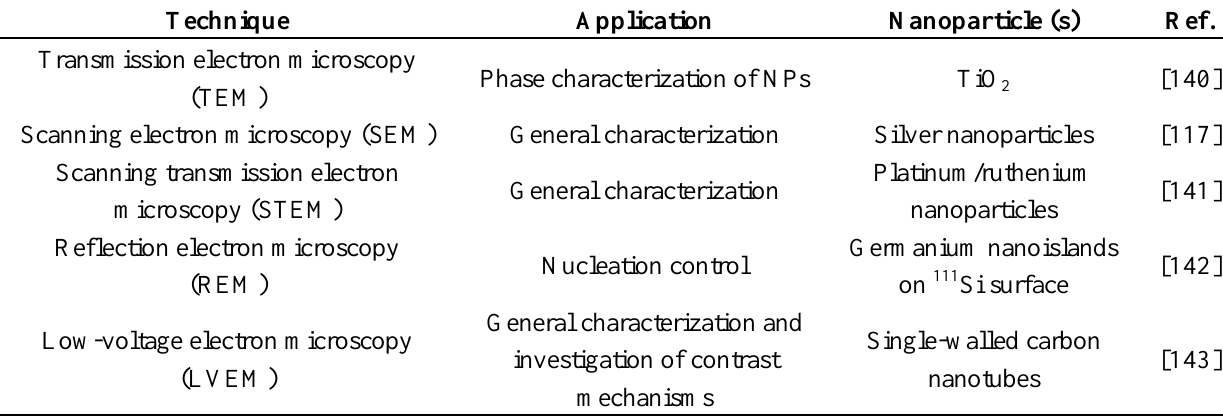
Table 2. The basic application of electron microscopy methods in NPs detection/visualization including the most common scanning (SEM) and transmission electron microscopy